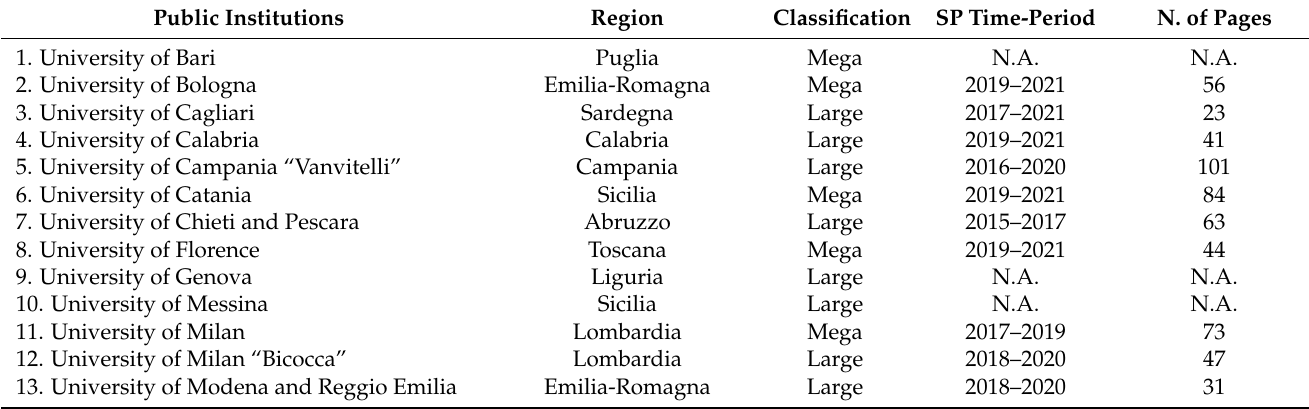
Table 1. Sample selected. Source: Authors’ elaboration from institutional websites. Legend: N.A. means Not Available. Public